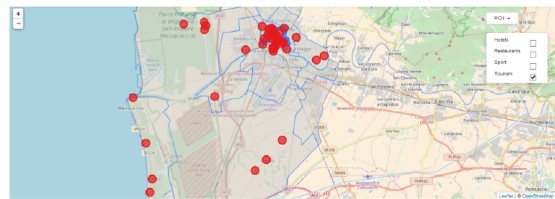
Figure 8. Map enriched with layer point of interest . In the figure, the layer containing hotel category is highlighted.